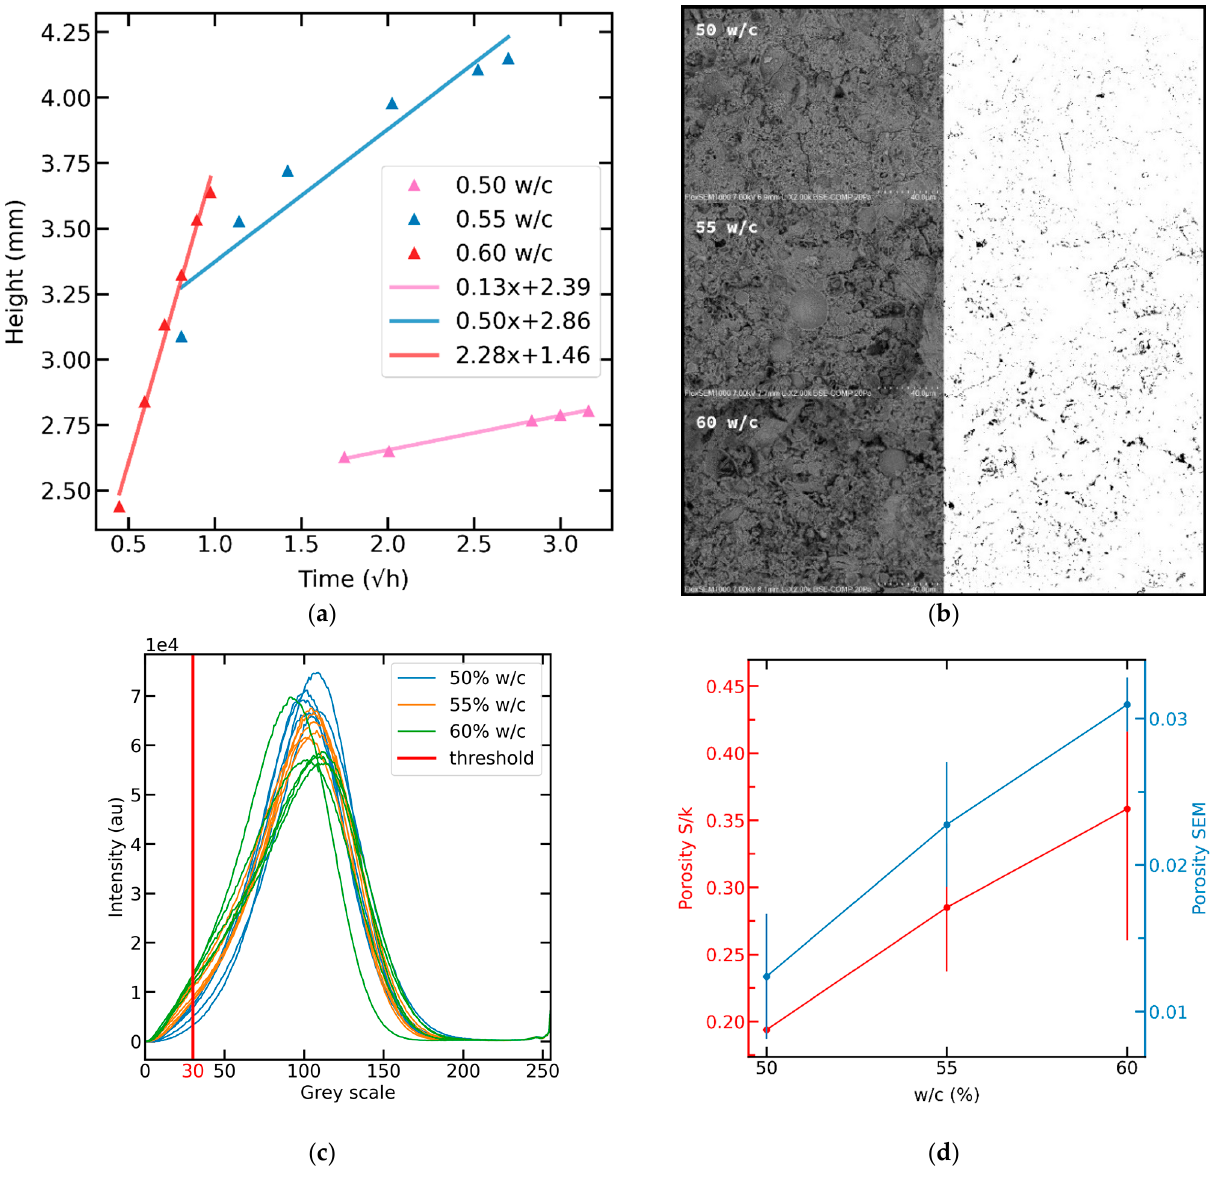
Figure 10. Volume of absorbed water per unit cross section over the square root of time for samples B (0.50 w/c ), C (0.55 w/c ) and F (0.60 w/c ) ( a ). SEM BSE images filtered with a Gaussian filter for samples B, C and F on the left and their porosity on the right ( b ). ( c ) Histograms of the grey scale of the images acquired through SEM and the 30/255 threshold in red. ( d ) Comparison of the porosity achieved through SEM and through Equation (4).